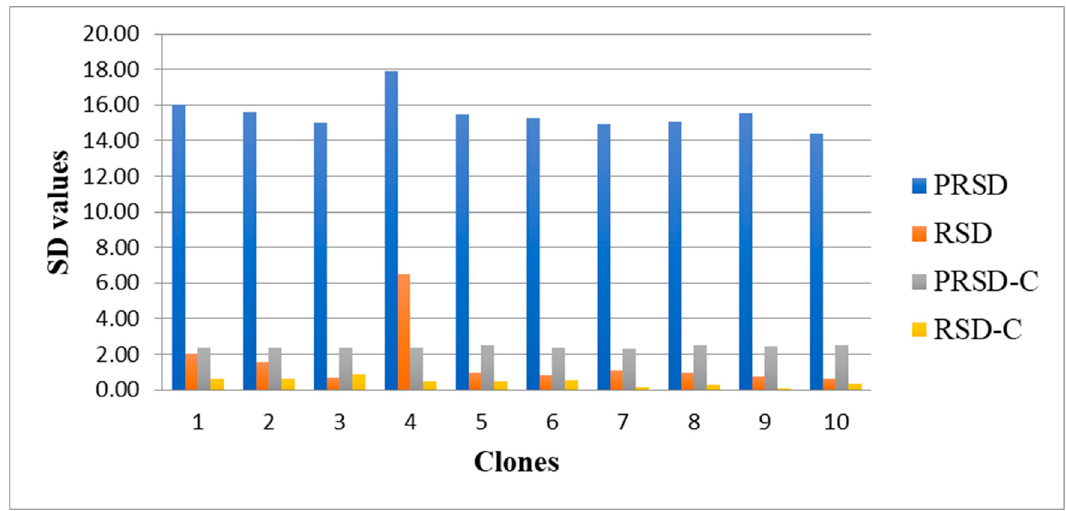
Figure 2. Predicted relative standard deviation (PRSD) and relative standard deviation (RSD) for iCheck values; PRSD-C = predicted relative standard deviation; RSD-C = relative standard deviation for Chroma Meter values; and SD = standard deviation.